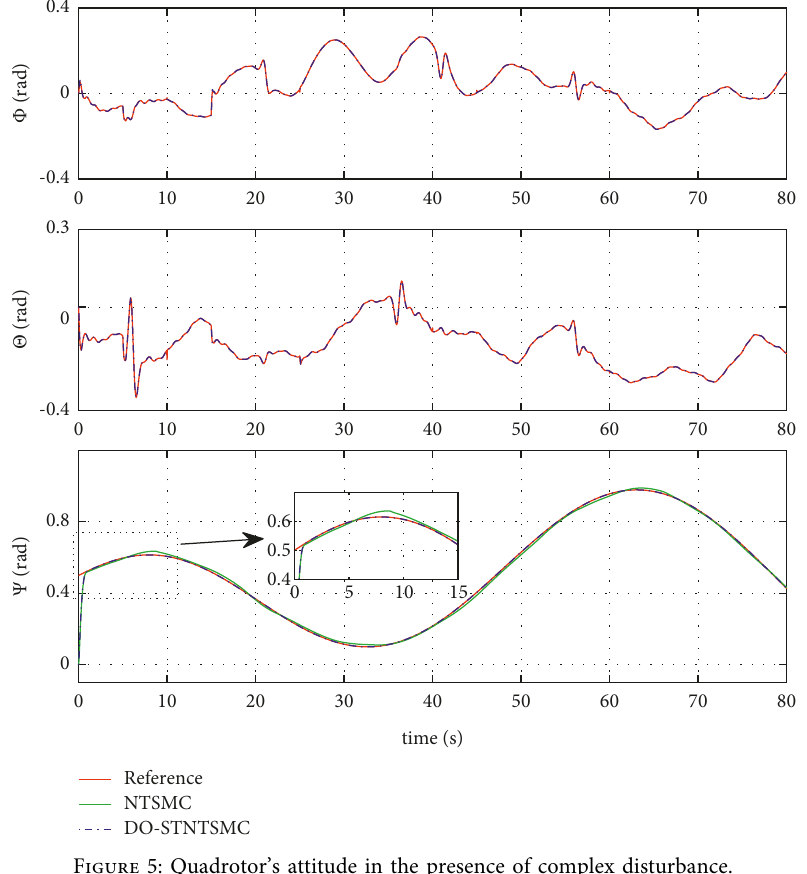
Figure 5: Quadrotor’s attitude in the presence of complex disturbance.